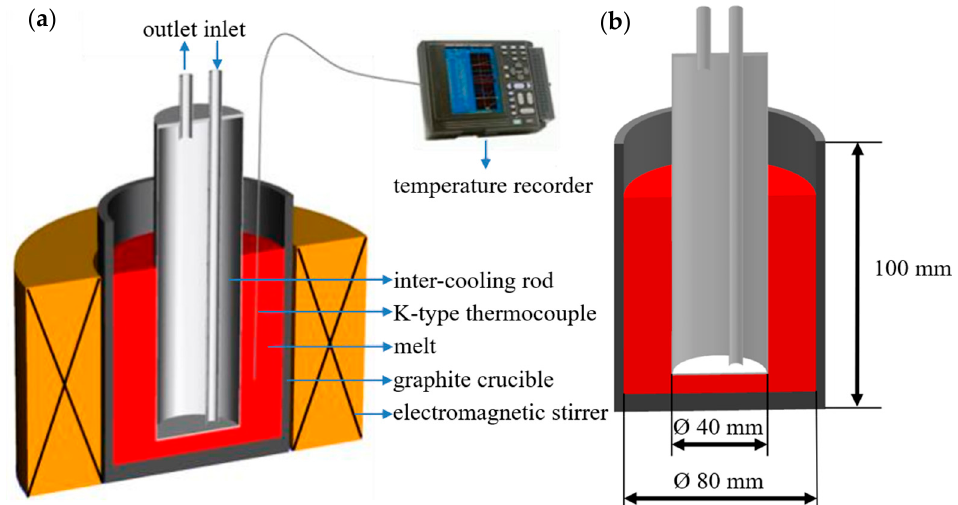
Figure 1. ( a ) Schematic view of the melt treatment apparatus by IC-AEMS, ( b ) the experimental dimensions of the graphite crucible and the inter-cooling rod [22].